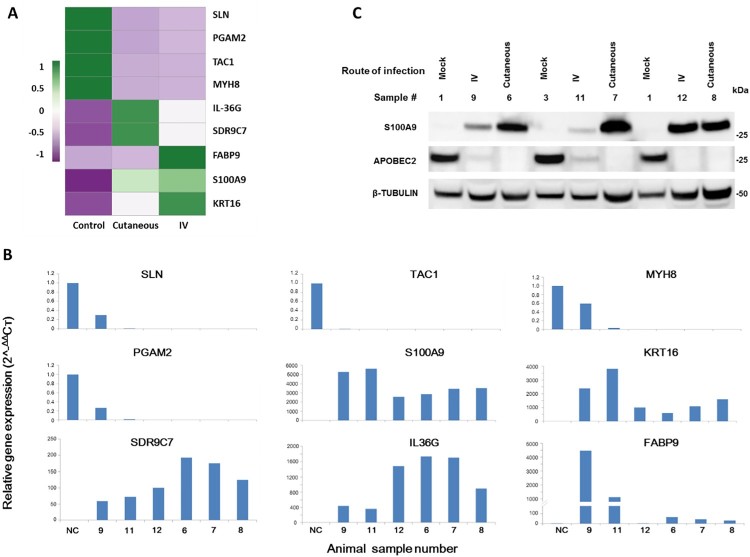
Representative host genes with differential expression in skin tumours
induced by both routes of CRPV infections. (A) Heat map showing the expression of 9
selected host genes chosen based on their expression abundance and cellular
functions. A colour scale bar represents relative gene expression level within
centred rows. Unit variance scaling has been applied to rows. Both rows and columns
are clustered using Euclidean distance and complete linkage. (B) Verification of
differentially expressed rabbit genes in RNA-seq results by real-time RT-qPCR.
Consistent with RNA-seq data, SLN, TAC1, MYH8, and PGAM2 were down-regulated in both
CRPV blood infection (Animal #9, #11, and #12) and CRPV skin infection (Animal#6,
#7, and #8) animals relative to those in normal control animals, whereas SDRC7,
KRT16, S100A9, IL36G, and FABP9 were up-regulated in both CRPV skin infection and
CRPV blood infection animals compared to normal controls. The Y-axis indicates
relative gene expression levels calculated by 2-ΔΔCт and the X-axis
indicate the different samples. NC, gene expression in the normal tissue, was set to
1 after normalization to GAPDH. (C) Western blot analysis of representative samples
from normal skin and warts induced by cutaneous or intravenous (IV) CRPV infection
for the expression of S100A9 and APOBEC2. Cellular β-tubulin served as a loading
control.